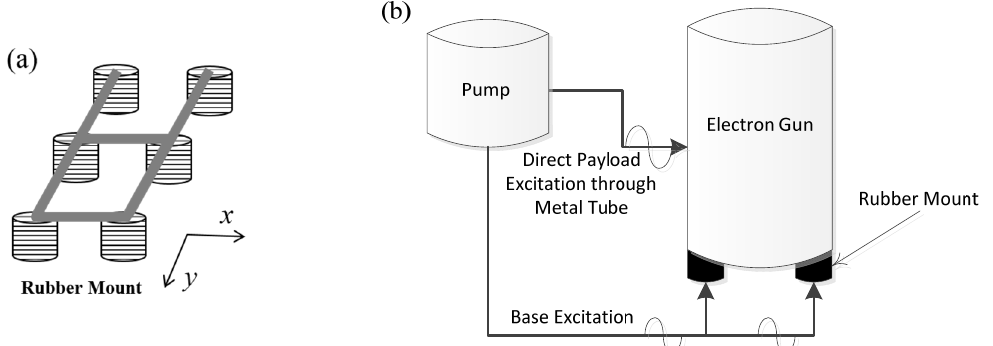
Figure 12. Schematic of the original six mounts supporting the electron gun.( a ) Configuration of rubber mounts; ( b ) Schematic of electron gun system.